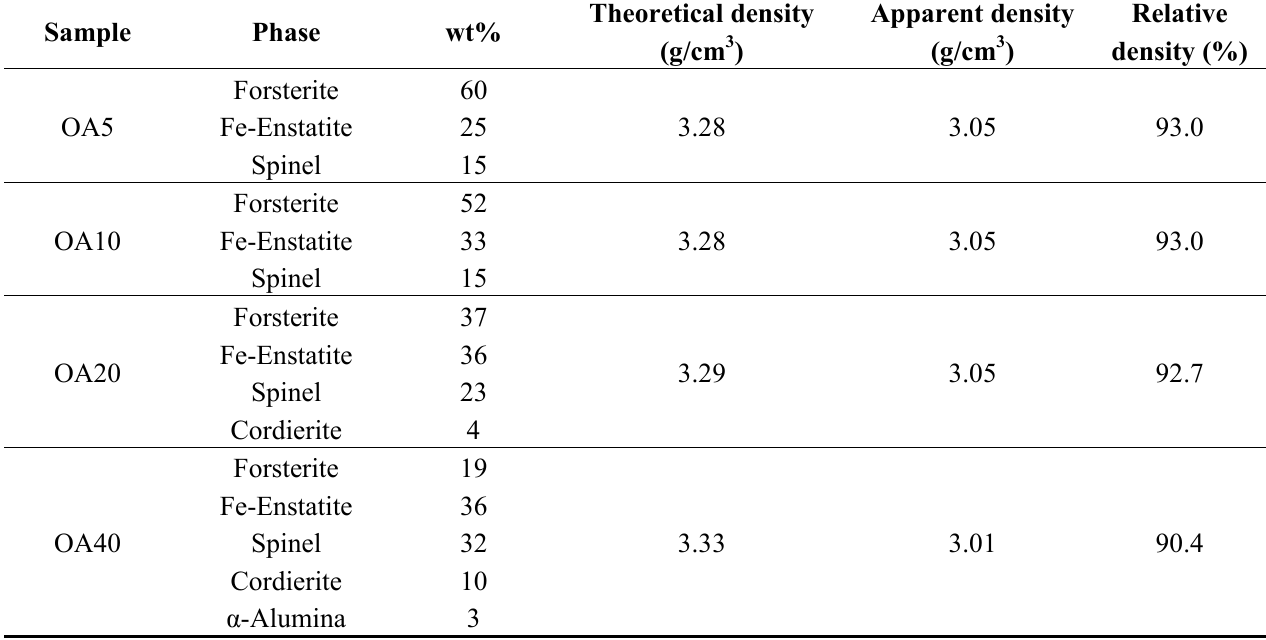
Table 1. Phases, corresponding percentage (wt%), approximate theoretical density (g/cm 3 ), apparent density and relative density of the materials fired 1 h at 1300